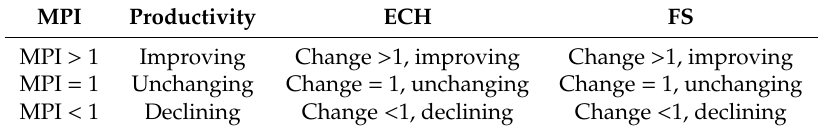
Table 1. Trends in Malmquist productivity index (MPI) and its components (source: Zhu 2011). MPI Productivity ECH FS MPI > 1 Improving Change > 1, improving Change > 1, improving MPI = 1 Unchanging Change = 1, unchanging Change = 1, unchanging MPI < 1 Declining Change < 1,